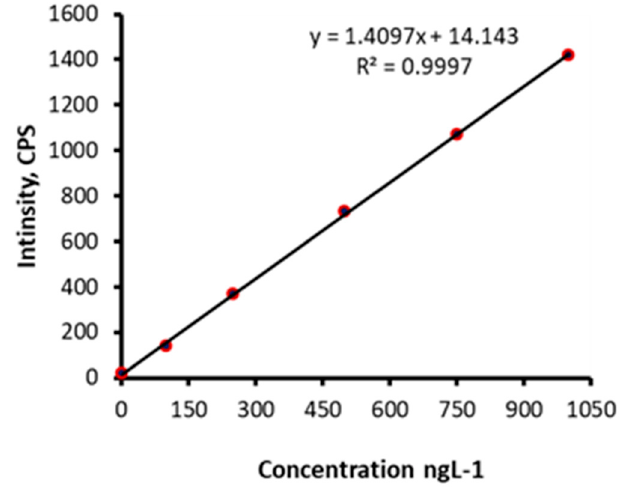
Figure 8. The calibration curve of Hg(II). The standard solutions were prepared using a solution of 2% HNO 3 containing 200 ppb Au(NP).